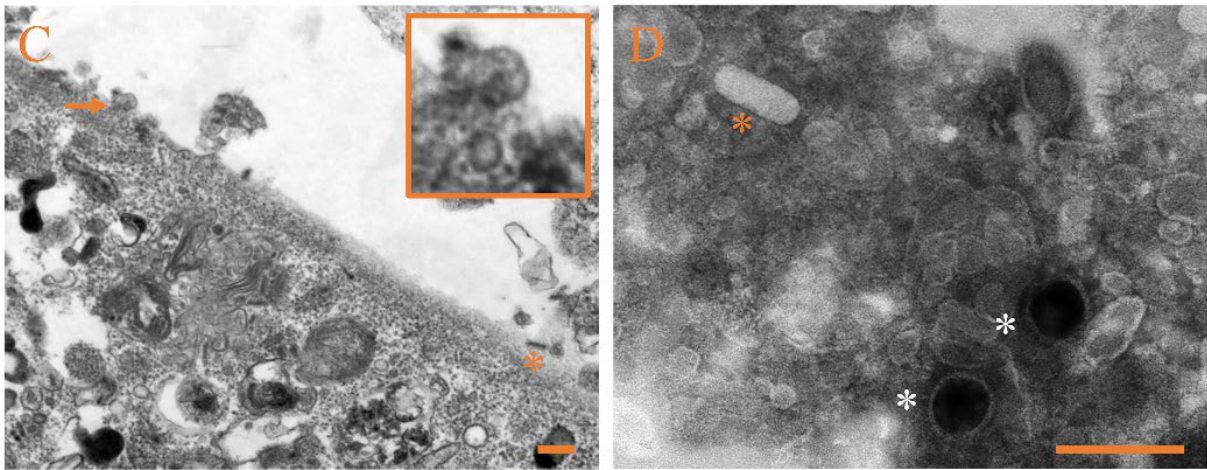
Figure 6. Transmission electron micrographs of JFB cells inoculated with CSBV Bces-Po19. ( A ) Arrows indicate the spherical virions; asterisk indicates viral-like tubular structure. ( B ) Asterisk indicates bacilliform virion. ( C ) Arrow indicates the spherical virion budding from the infected cell membrane; asterisk indicates bacilliform virion. ( D ) Transmission electron microscopy (negative staining) of purified virions from the JFB cell supernatant. Orange asterisks indicate bacilliform virions; white asterisks indicate spherical virions. Scale bars: 200 nm.